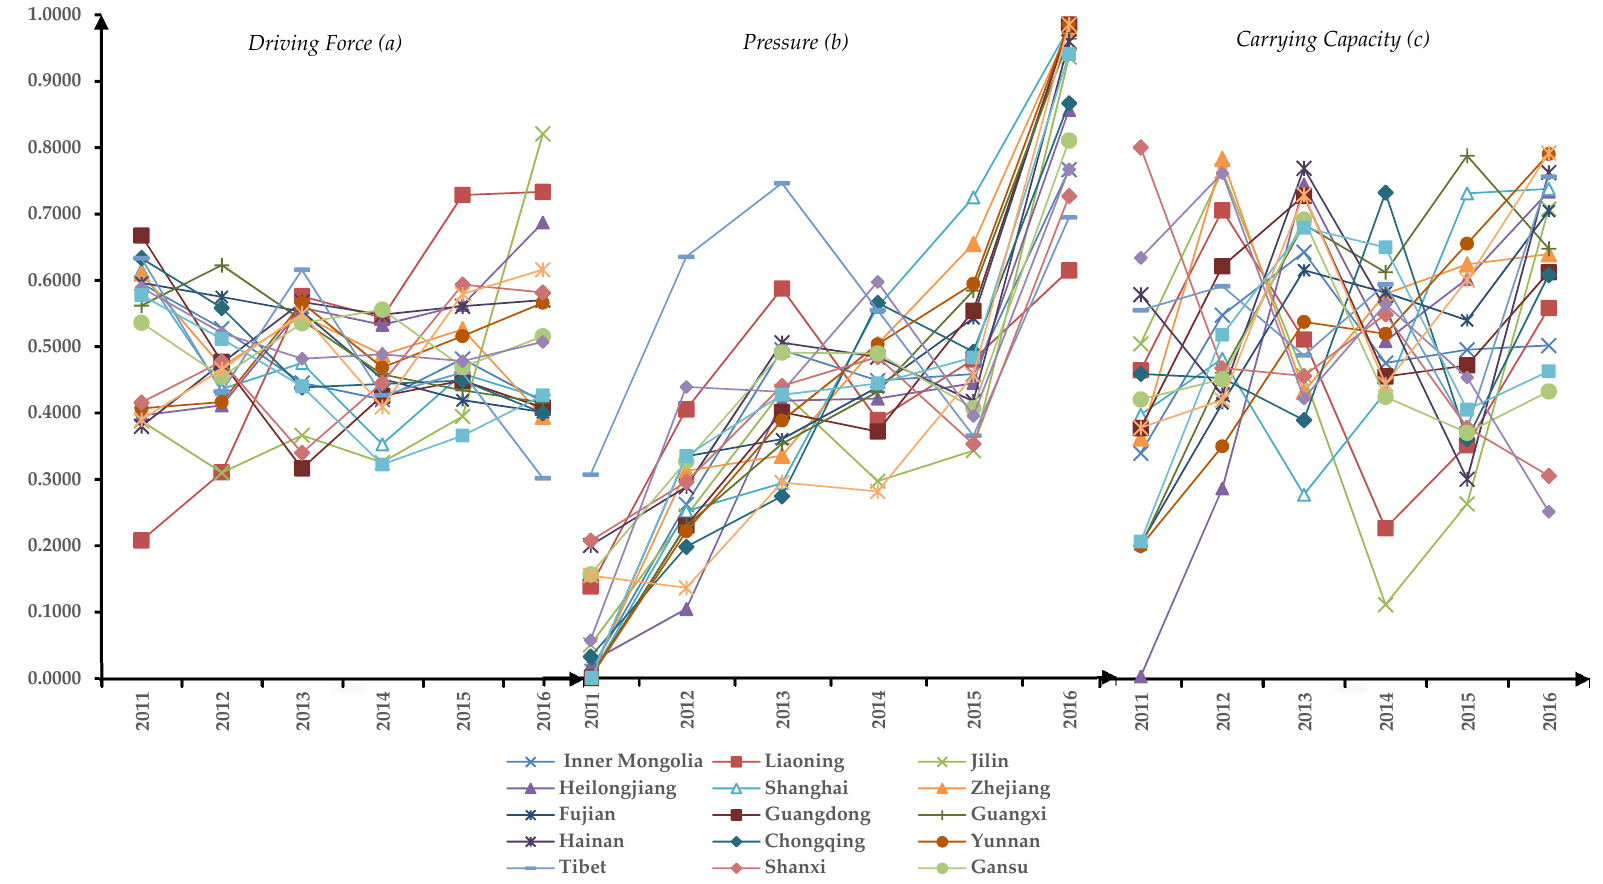
Figure 5. Driving Force ( a ), Pressure ( b ), and Carrying Capacity ( c ) subsystems in the One Belt and One Road Area of China.